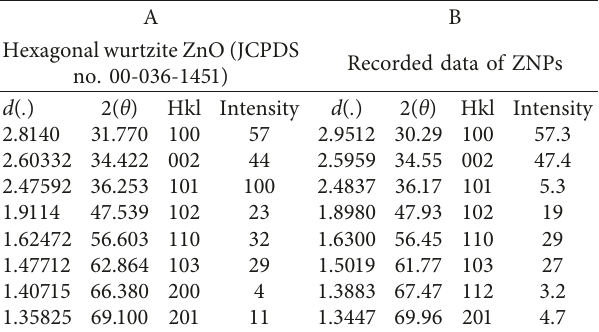
Table 2. From the XRD spectrum pattern analysis, the peak intensity, full width at half maximum (FWHM) data and position, and the diffraction peaks located at 31.19 ° , 34.55 ° , 36.17 ° , 47.93 ° , 56.45 ° , 61.77 ° , 67.47 ° , and 69.96 ° have been keenly indexed as the hexagonal wurtzite phase of ZnO with lattice constants a � b � 0.324 nm and c � 0.521 nm (JPCDS card number: 36–1451) and correspond to peaks of 100, 002,